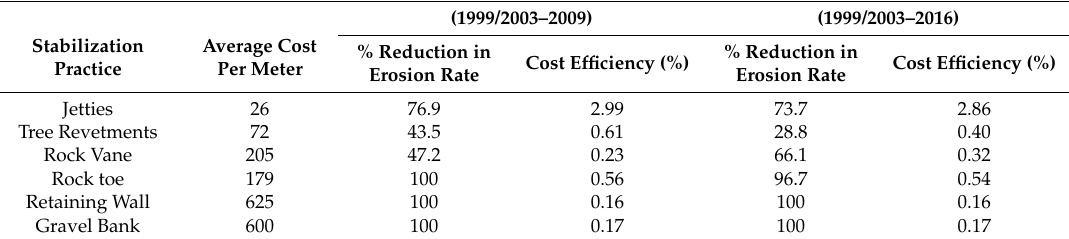
Table 3. Percent reduction in streambank erosion rate and cost efficiency for each stabilization practice for the post-stabilization period (1999/2003–2009) and the period from 1999/2003–2016, which included the flood and post-flood